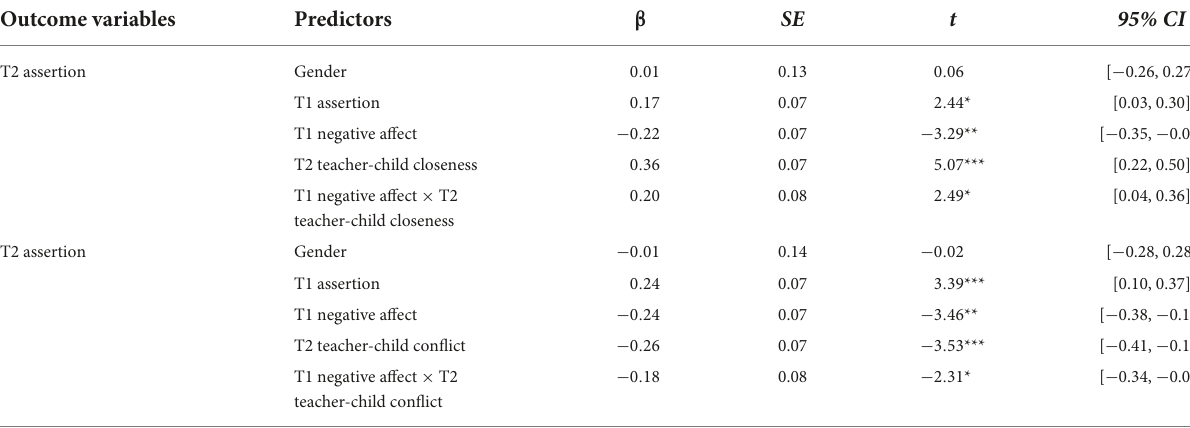
TABLE 4 Moderating effect of negative affect and teacher-child relationship on the assertion. Outcome